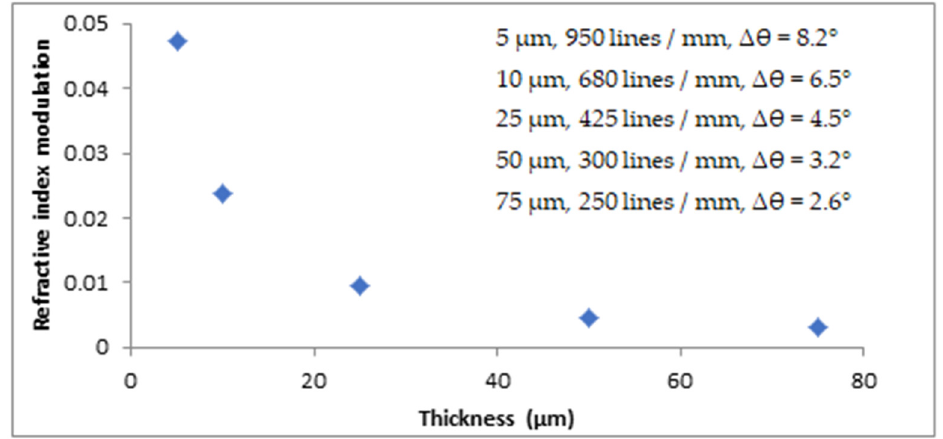
Figure 3. Refractive index modulation required at different layer thicknesses for achieving 100% diffraction efficiency, showing the spatial frequencies required at that thickness for Q = 10 along with the resulting full width half max angle ( Δθ ) of Bragg curve (angular selectivity).